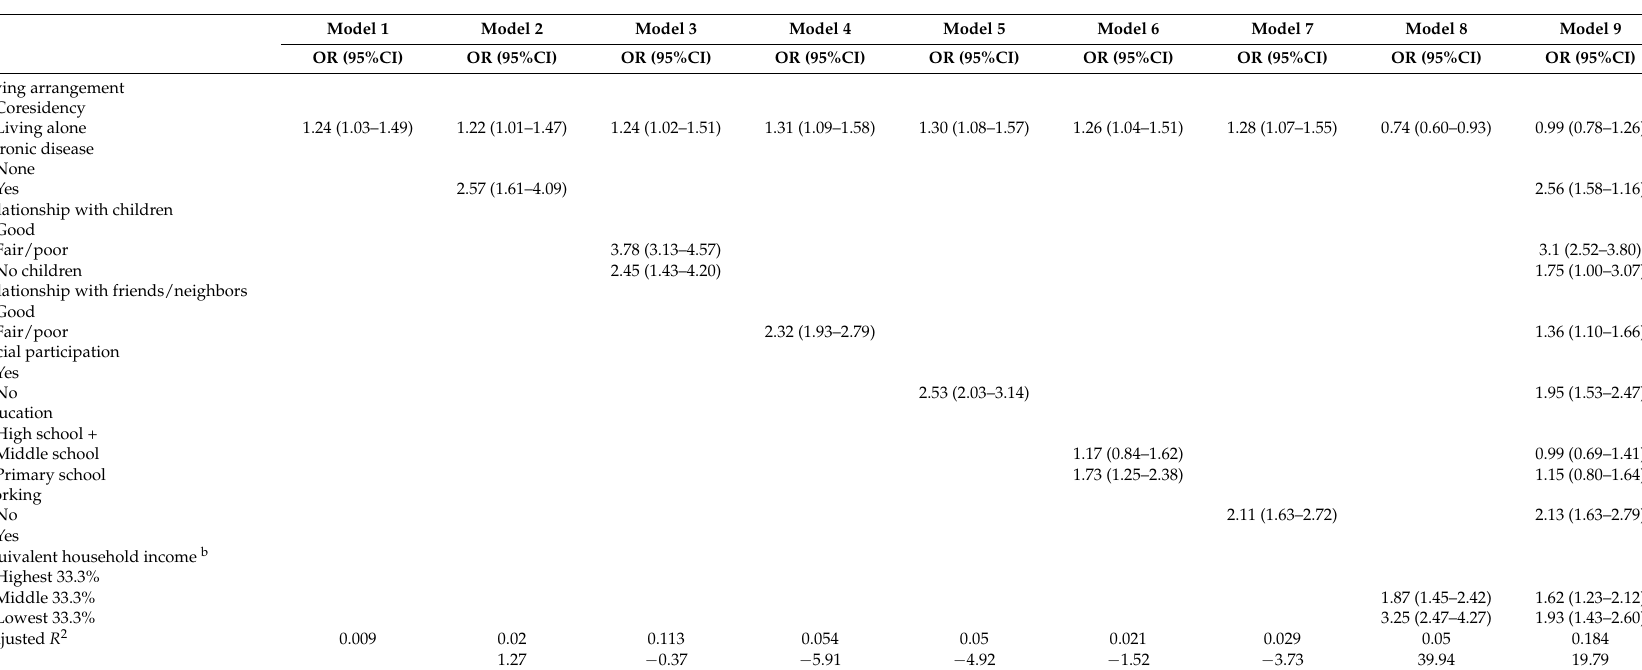
Table 2. The explained fractions (XF) a of the health, social ties, and socioeconomic status calculated from odds ratios (95% confidence intervals [CI]) for depressive symptoms in elderly Korean widows living